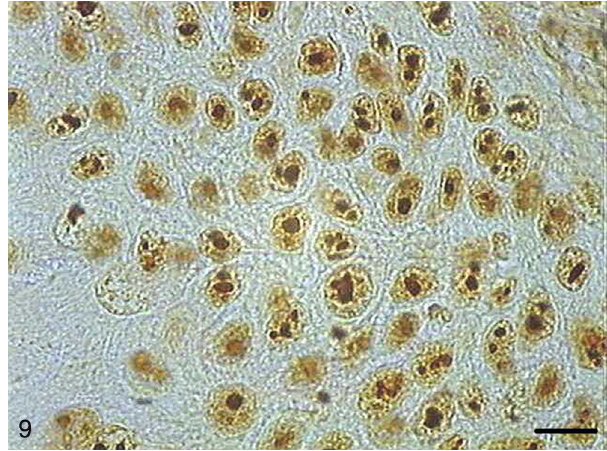
Figure 7 Papilloma. Micrograph of papilloma with exophytic projections extending below the surface of the mucosa (HE, bar = 100 (cid:2) m).